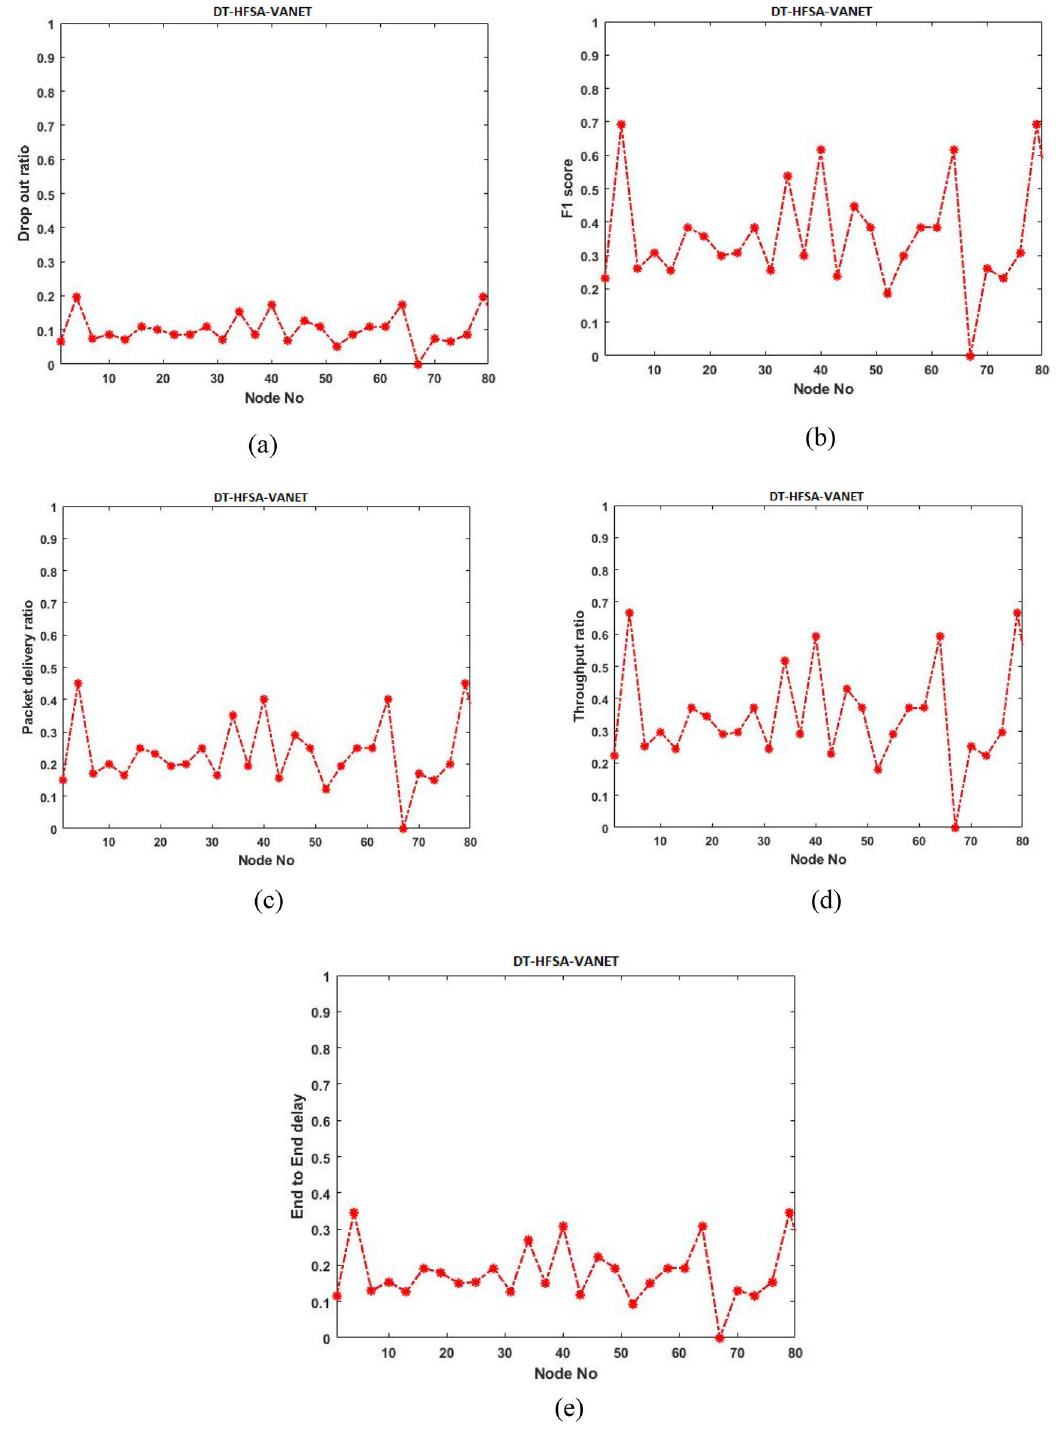
Figure 14. ( a ) Dropout ratio, ( b ) F1 score, ( c ) packet delivery ratio, ( d ) Throughput ratio, ( e ) End to end